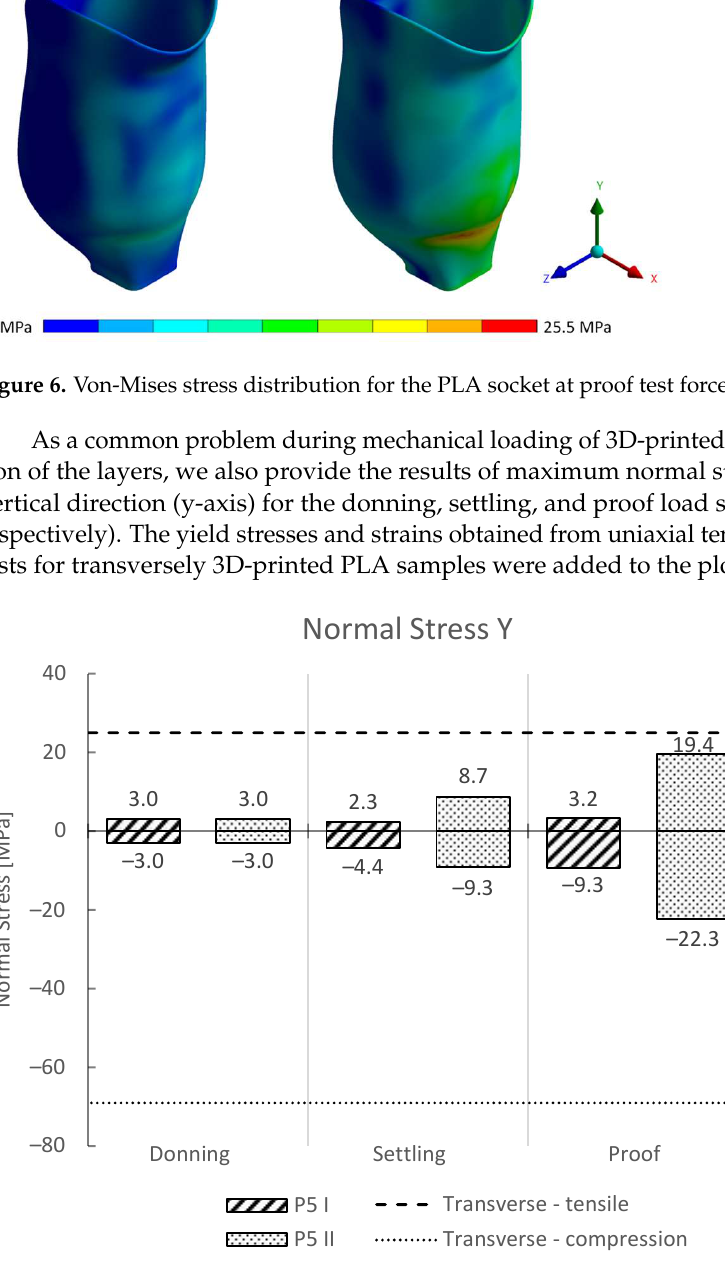
Figure 7. Results of normal stress in the y-axis. The negative values represent compression, while the positive values represent tensile stress. Additionally, the transverse yield stress is shown with horizontal dashed lines.